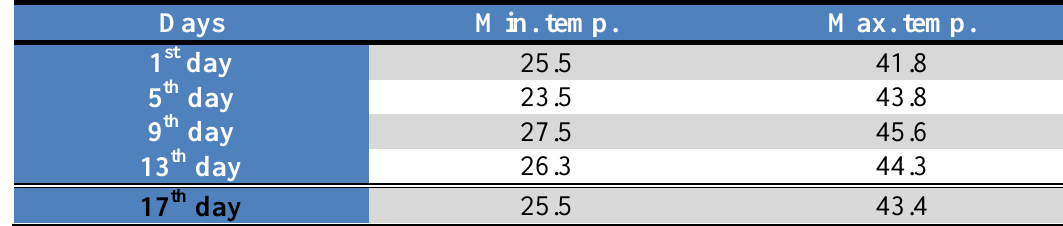
Table1. Minimum and maximum temperatures (°C) in Mosul c during this study) Days Min. temp. Max.